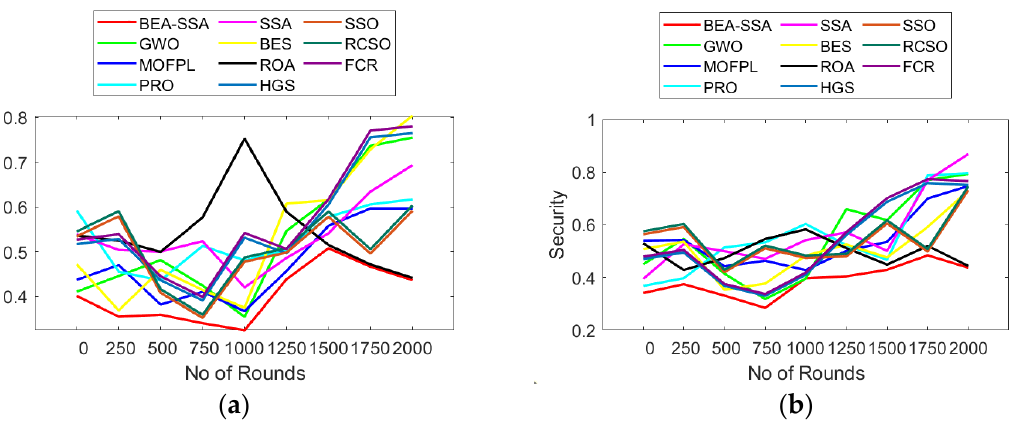
Figure 13. Security analysis using BEA-SSA over other conventional models [20–22,26] for node count of ( a ) 50 ( b ) 100.